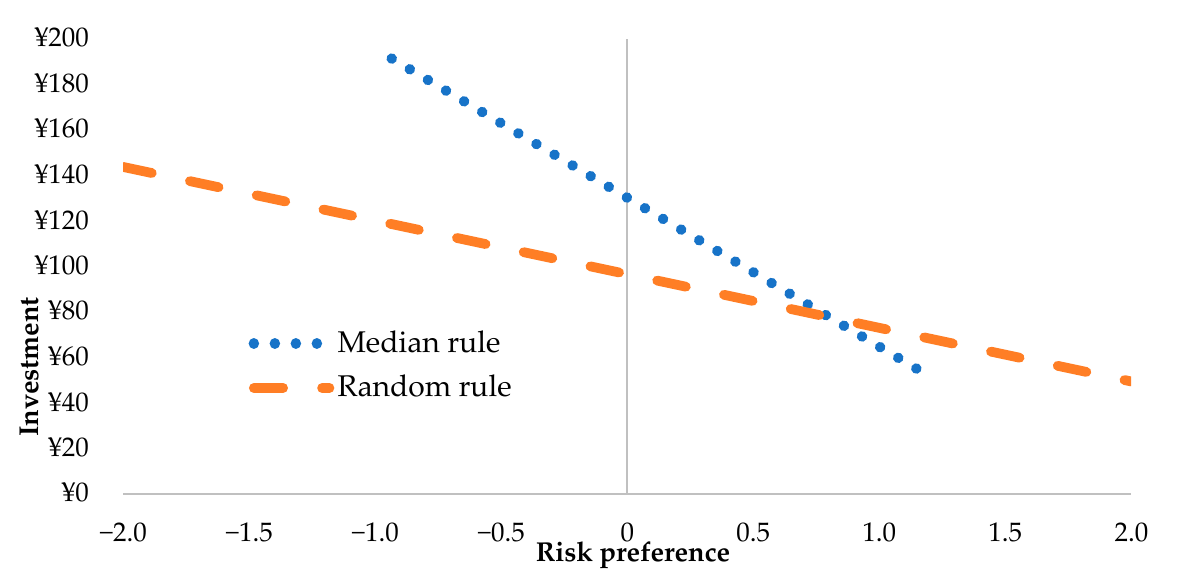
Figure 2. Scatter plots with a regression line: Investment (Group-choice sub-sample).